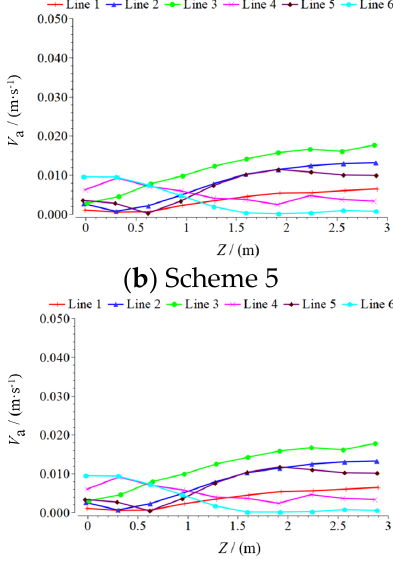
Figure 13. Diagram of axial velocity on the inlet of the sump 1#.